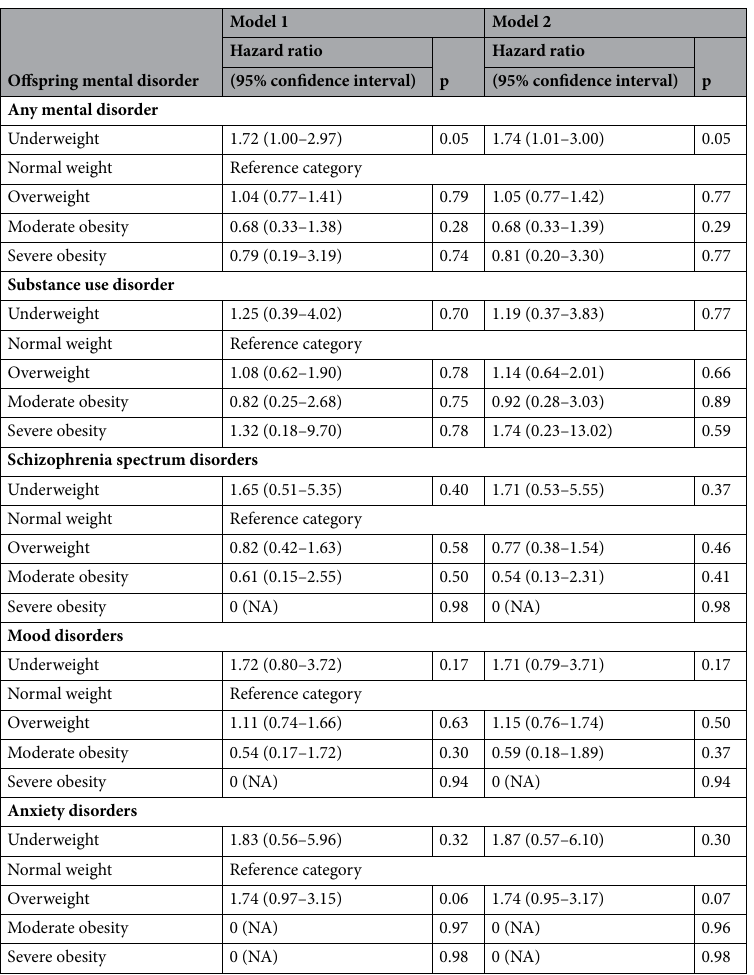
Table 4. Maternal body mass index in pregnancy and hazard of mental disorders in offspring born 1950– 1974. Model 1 is adjusted for the sex and birth year of the child and gestation when weight was measured. Model 2 is adjusted also for maternal smoking and hypertensive disorders in pregnancy, maternal hospital- treated and self-reported mental disorders, age at delivery, parity and the social class of the family. NA not